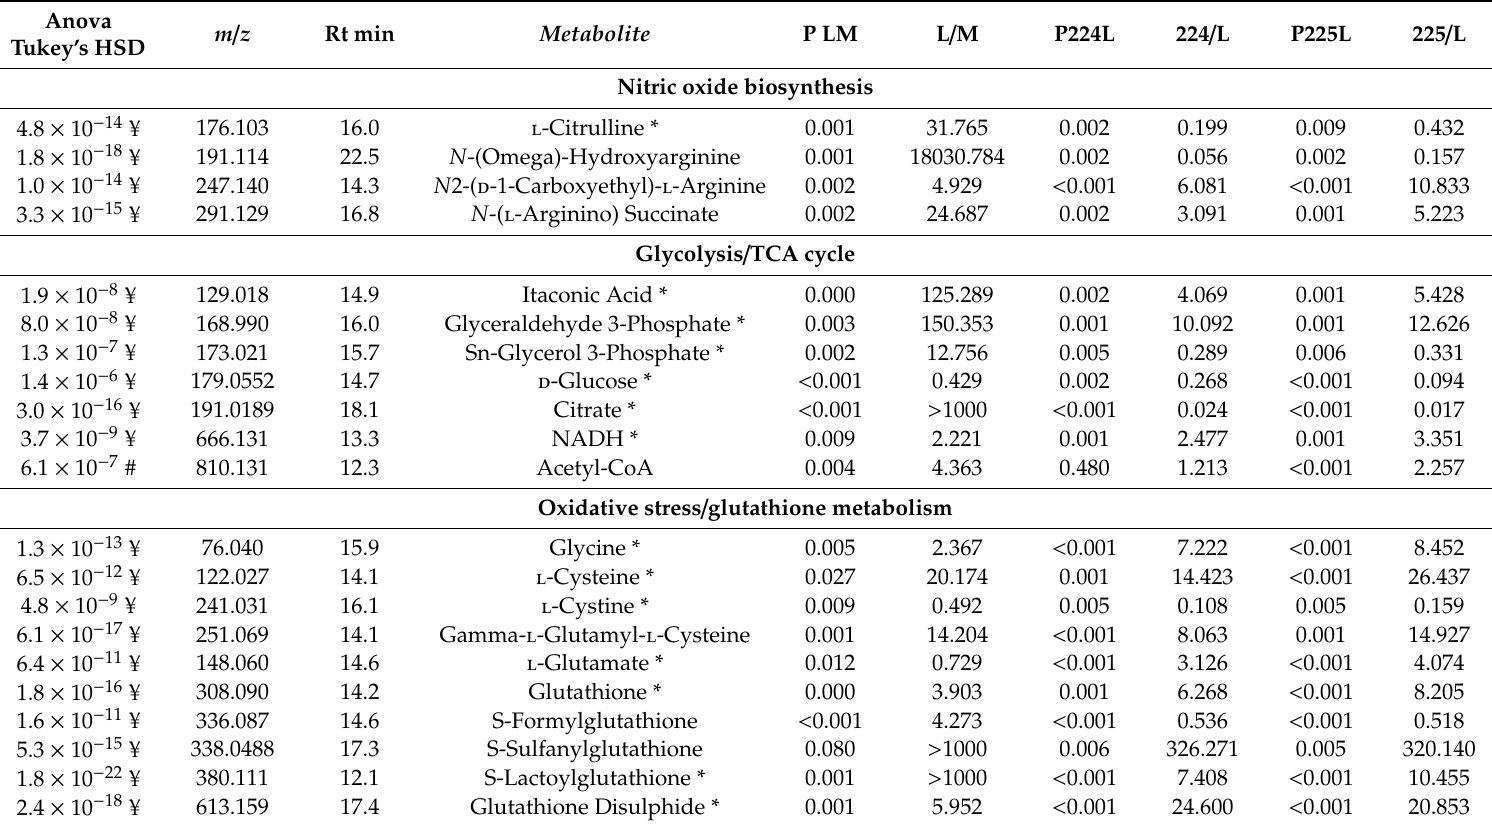
Table 1. Metabolites in LPS-stimulated macrophages that are significantly a ff ected by propolis. §—significantly di ff erent between all six treatments (LPS-M, LPS-224, LPS 225, 224-M, 225-M, and 224–225); ¥—Propolis treatments significantly di ff erent from controls but not each other; € —Propolis treatments di ff erent from LPS but not the control; #—No di ff erence between 224 and LPS but LPS and 225 di ff er and treatments di ff er from control. The false discovery rate statistic (FDR) indicates all p values < 0.05 are significant. * Matches retention time of standard. p = p value ( n = 6 for each treatment). P LM = p value LPS vs. medium treatment; P224L = p value for propolis sample 224 + LPS vs. LPS; P225L = p value propolis sample 225 + LPS vs. LPS. L / M = LPS treated over medium-treated control, 224 / L = propolis